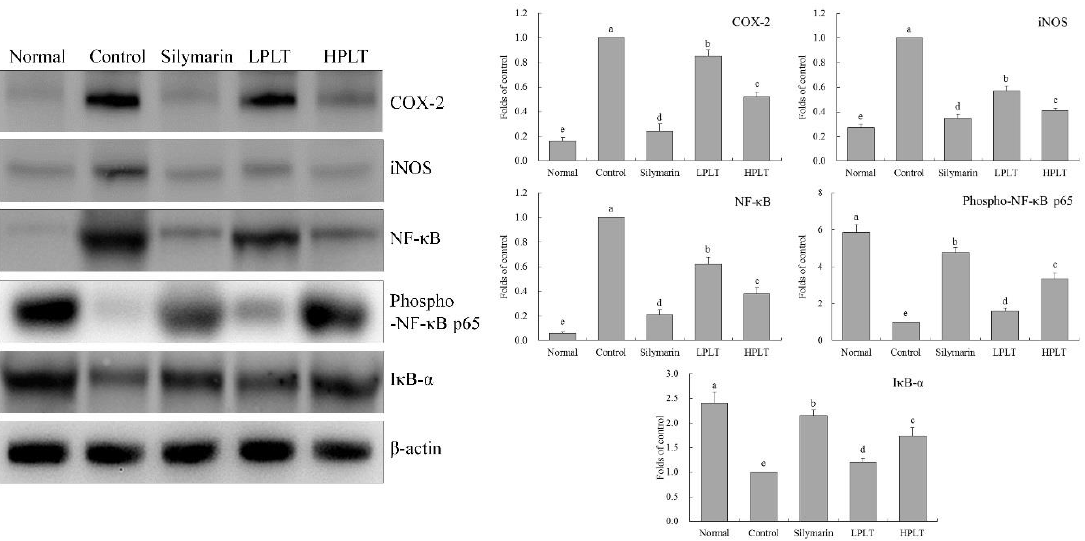
Figure 5. COX-2, iNOS, NF- κB, phosphorylated (p)-NF- κB p65 , and IκB - α protein expressions in hepatic tissue of experimental mice with CCl 4 -induced hepatic damage. Values presented are the means ± standard deviation ( N = 3/group). a – e Mean values with different letters in the same bars are significantly different ( p < 0.05) and those with the same letter in the same column are not significantly different ( p > 0.05) according to Duncan’s new MRT. Silymarin group: 50 mg/kg b.w. silymarin treatment dose; LPLT group: 50 mg/kg b.w. polyphenols of Liubao tea (PLT) treatment dose; and HPLT group: 100 mg/kg b.w. polyphenols of Liubao tea (PLT) treatment dose.